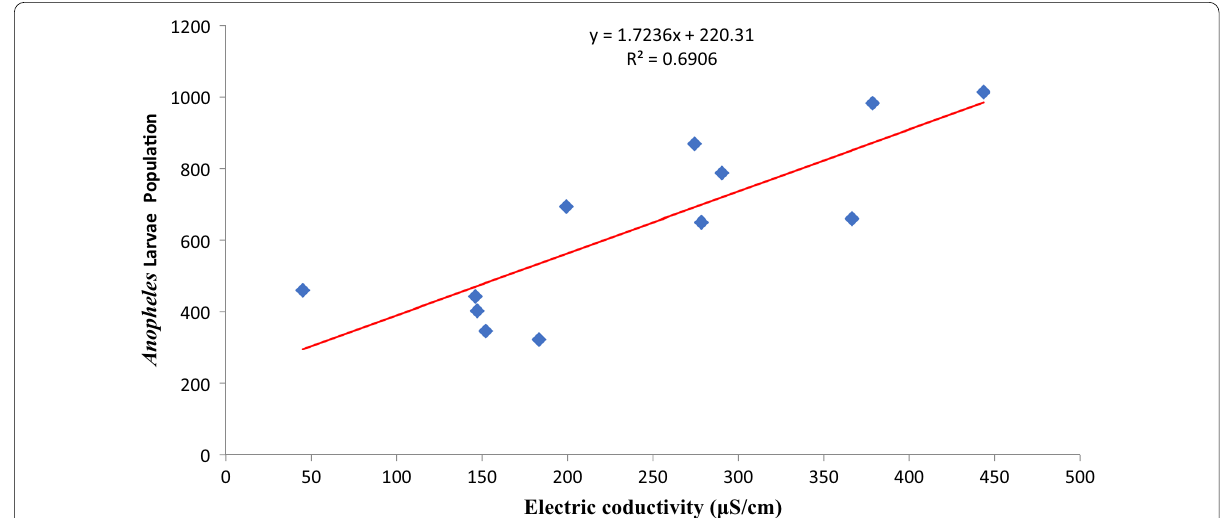
Fig. 3 Regression relationship between Anopheles larvae population and electrical conductivity values (µS/cm) of habitats in Akure North